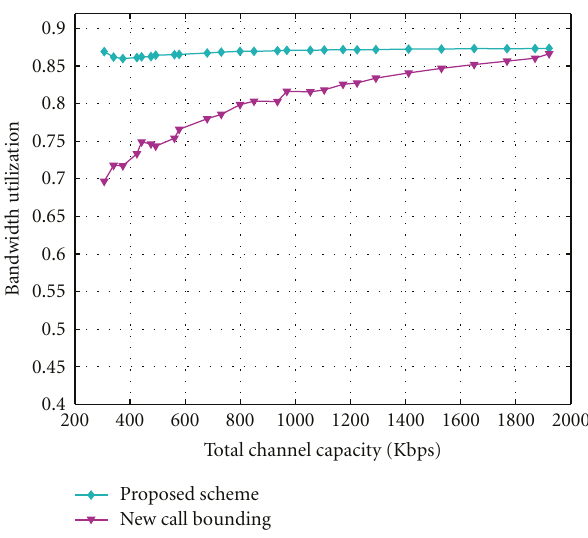
Figure 7: Bandwidth utilization versus total channel capacity.